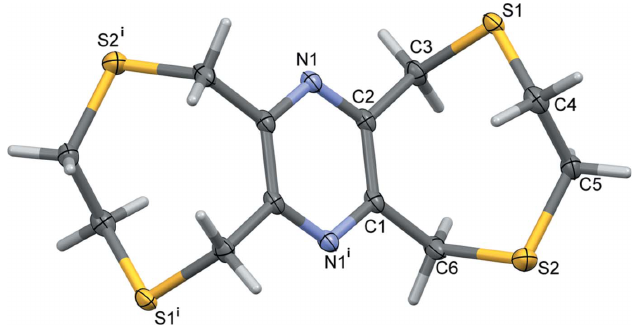
Figure 1 The molecular structure of L1 , with atom labelling [symmetry code: (i) (cid:4) x + 1, (cid:4) y + 1, (cid:4) z + 1]. Displacement ellipsoids are drawn at the 30% probability level.